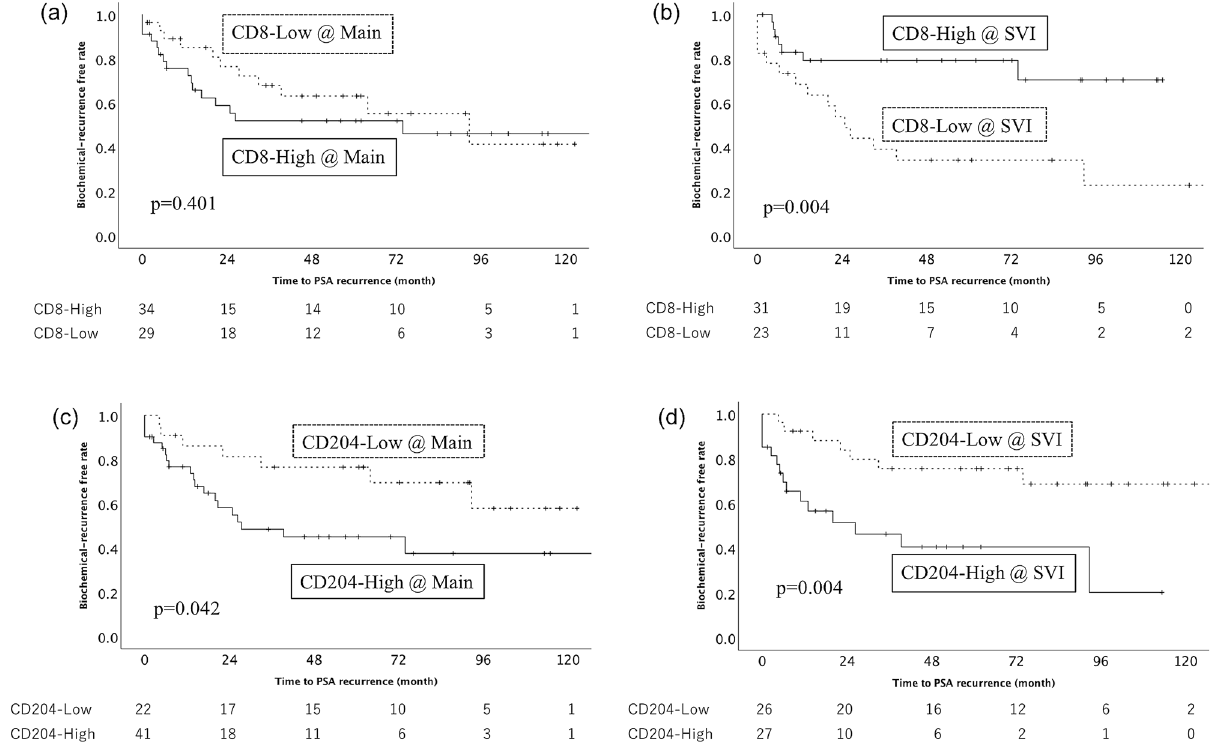
Figure 1. The Kaplan–Meier analysis of the recurrence-free survival of patients with seminal vesicle invasion according to the CD8 + cell in the main tumor area (a, p = 0.401) and seminal vesicle invasion area (b, p = 0.004) and the CD204 + cell in the main tumor area (c, p = 0.042) and seminal vesicle invasion area (d, p = 0.004). Solid square means higher density, and dotted square means lower density.